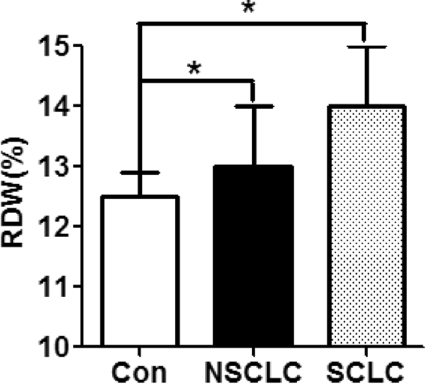
Figure 1. RDW levels in the NSCLC, SCLC, and control groups. RDW levels in NSCLC patients (n = 338), SCLC patients (n = 109), and healthy controls (n = 302) were tested by hematology analyzer. Data are expressed as median and interquartile range. * p <